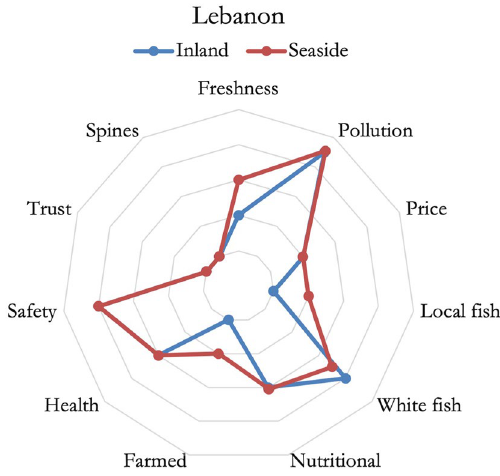
Fig. 4 Importance of fish attributes in defining consumer’s preferences,